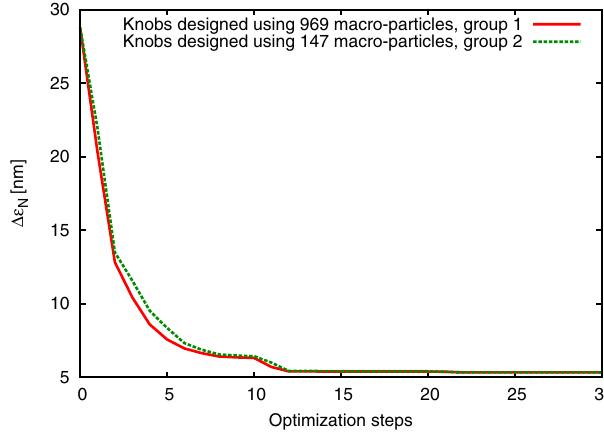
FIG. 18. Root-mean-square and maximum displacements of 662 accelerating structures controlled by ten knobs after correc- tion of each of 100